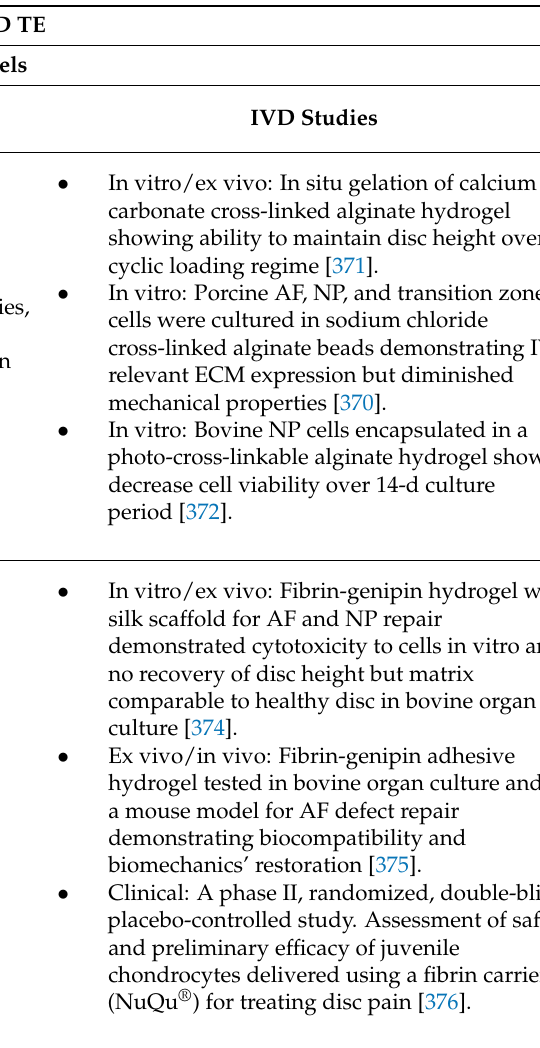
Table 1. The major natural and synthetic biomaterials that have been studied for their potential use for treating intervertebral disc degeneration (DD). In the context of intervertebral disc (IVD) applications, potential strengths (+) and drawbacks ( − ) for each material are provided as well as the IVD-specific studies accompanying